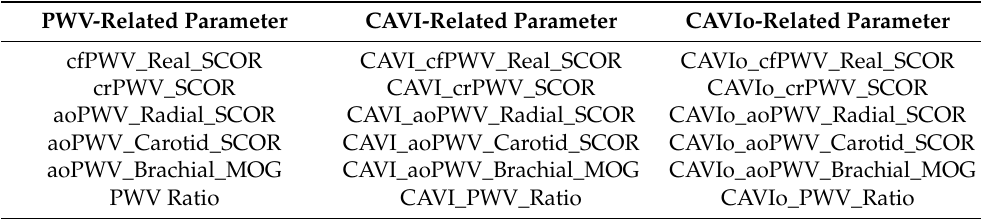
Table 1. PWV-, CAVI- and CAVIo-related